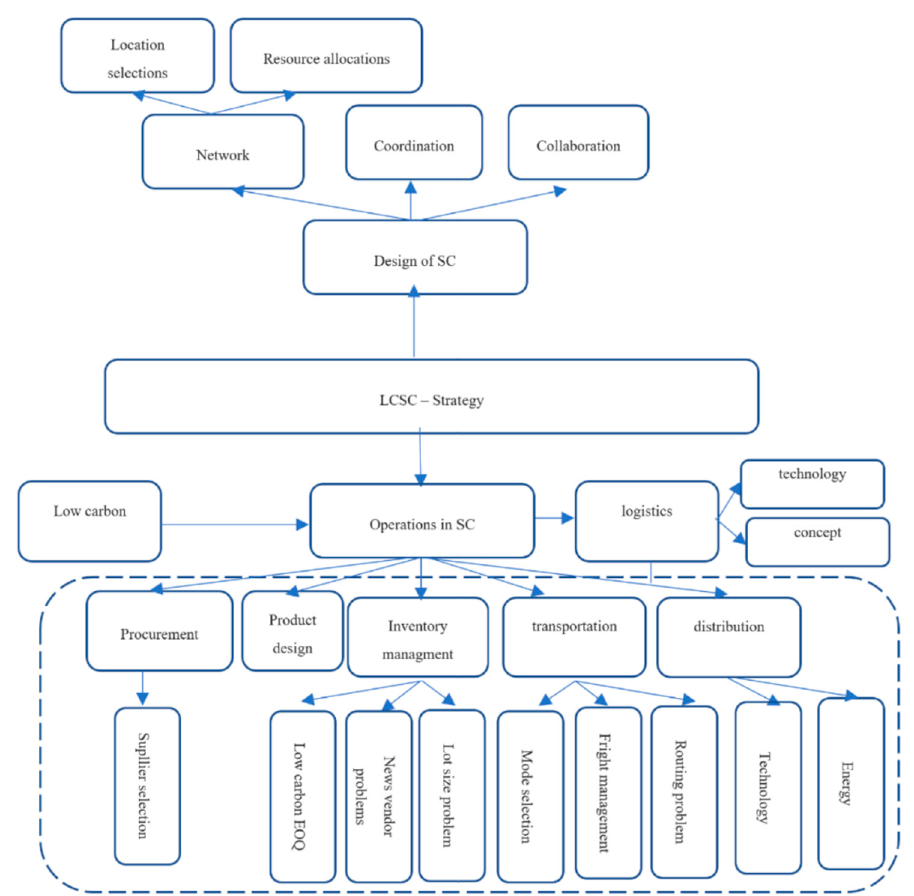
Figure 4. LSC Strategy—design and operation of supply chain. Source: own elaboration on the basis of [27,32].